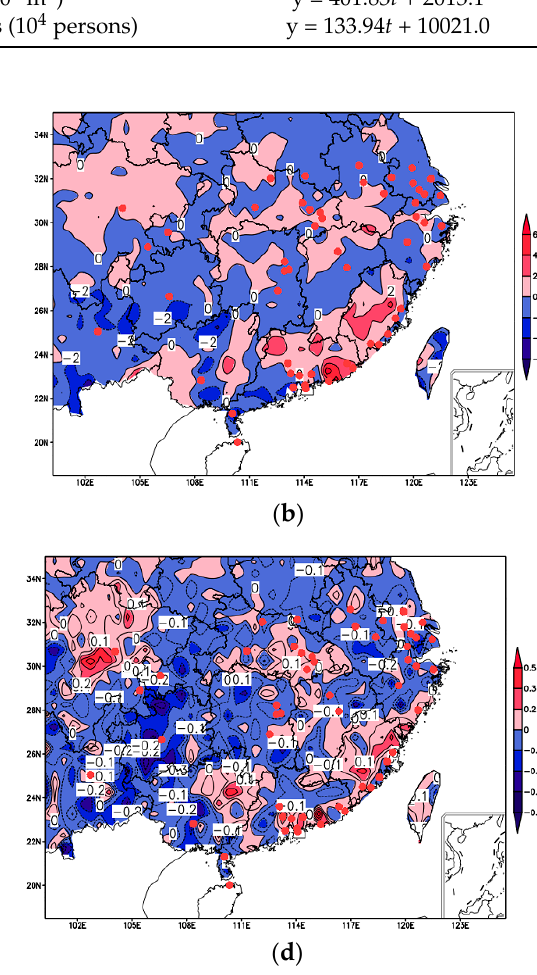
Figure 2. Contour plots of the 17-year (1998–2014) trends over South China: ( a ) warm-season (May–September) precipitation (mm · mon − 1 · year − 1 ), ( b ) convective precipitation (mm · mon − 1 · year − 1 ), ( c ) non-convective precipitation (mm · mon − 1 · year − 1 ), ( d ) convective precipitation percentage (% · year − 1 ), based on 0.5 ◦ *0.5 ◦ TRMM PR rain rate Table 2. The trend of rain, CAPE, TCWV, skin-temperature, sensible heat flux, boundary layer height, evaporation, 1000 hPa specific humidity in warm season during 1998 to 2014. Urban Clusters.